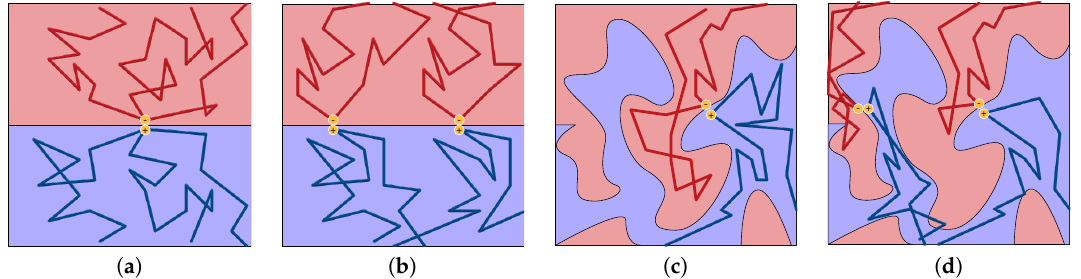
Figure 3. Illustration of the different organic solar cell setups. A simple organic solar cell consists of two layers while single ( a ) or multiple excitons can be considered ( b ). More complex morphologies reduce interface distances and can also be considered with single ( c ) or multiple excitons ( d ). We use a color scheme assigning red to donor material and trajectories and blue to acceptor material and trajectories for all